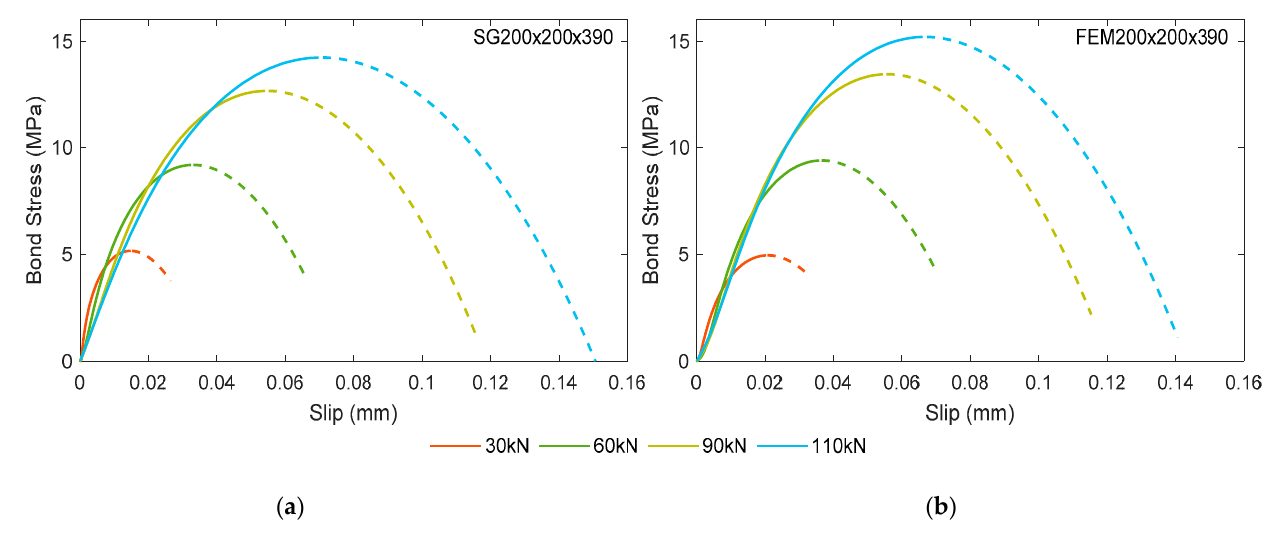
Figure 8. Bond stress-slip behavior at different load levels of: ( a ) SG200×200×390 and ( b ) FEM200×200×390.